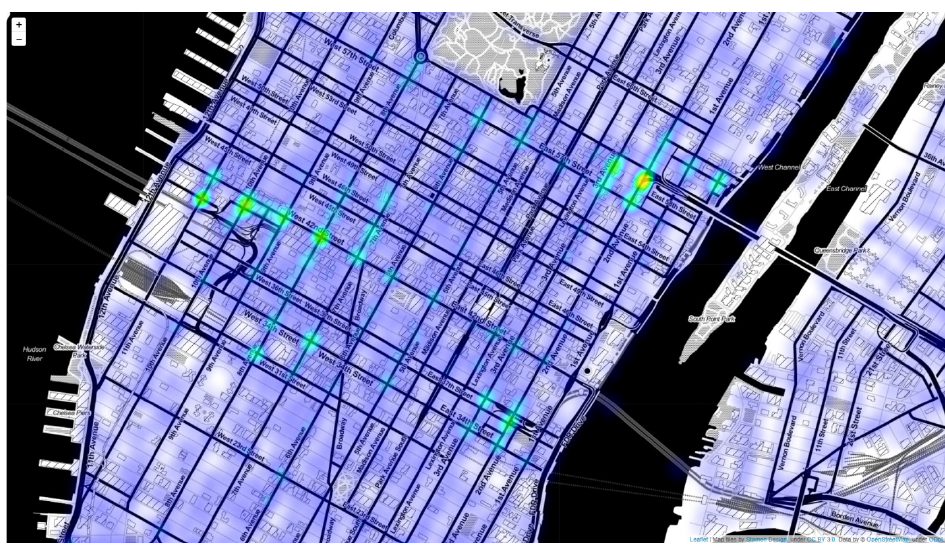
Figure 14. Zoomed-in MVTC heatmap of the city.